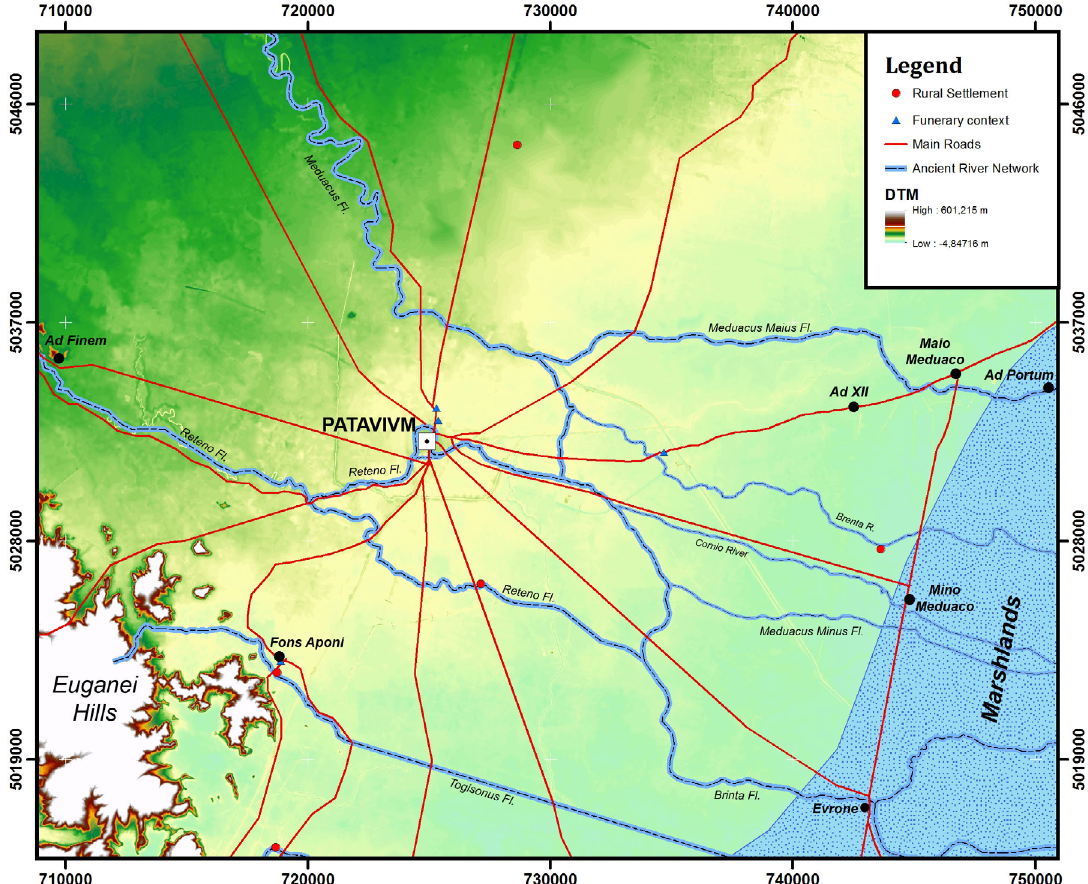
Fig. 12 The road network around Patavium between the 5th and 6th century